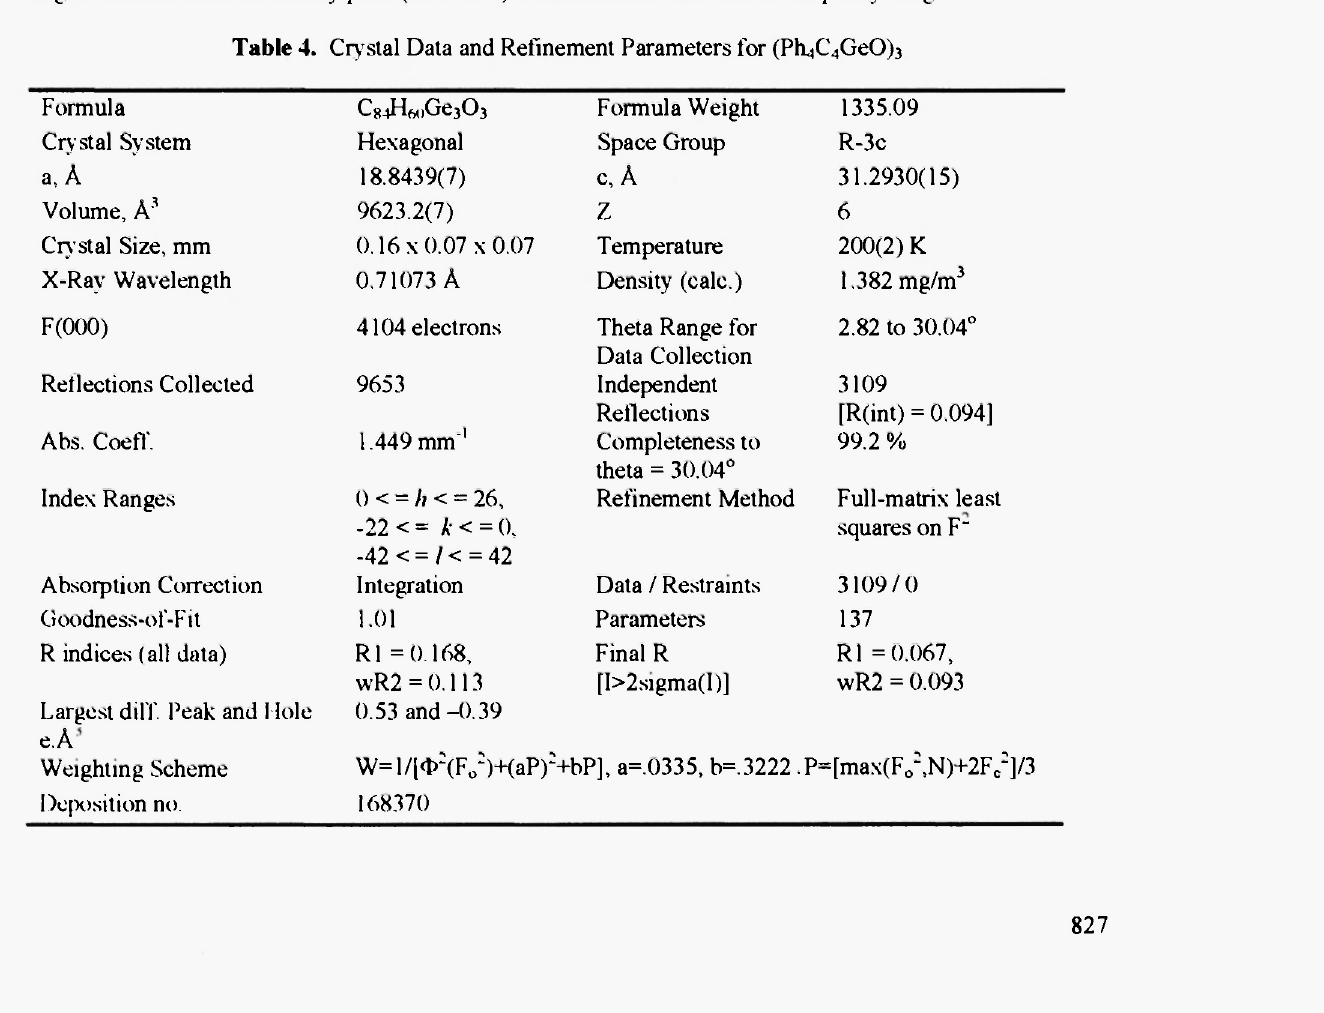
Table 4. Crystal Data and Refinement Parameters for (Ph 4 C 4 GeO)